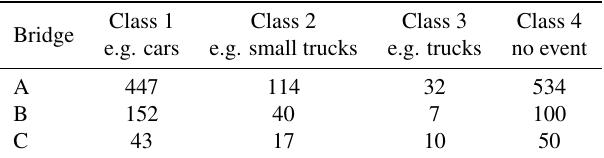
Figure 7. Schema of the methodological approach. Table 2. Number of labelled events per bridge and class. The labelling of the data of Bridge A and B has been done primarily by monitoring the bridge surface via UAV. The labels of Bridge C have been created manually.